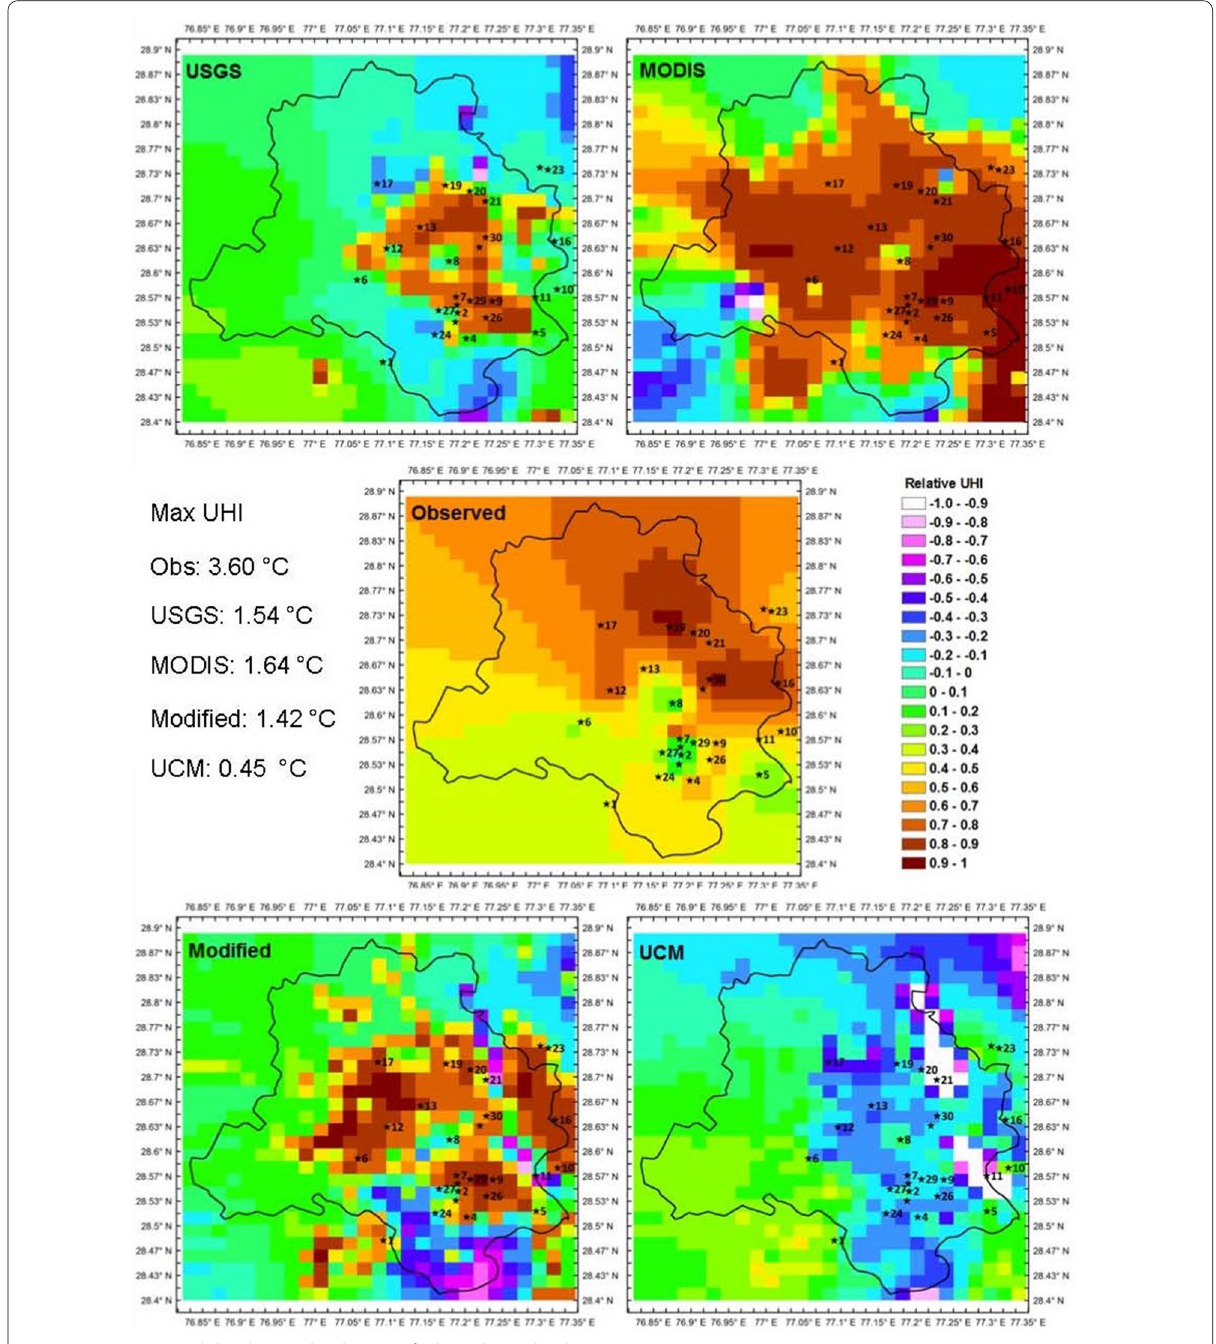
Fig. 9 Daytime (1500 h local time) distribution of relative heat island